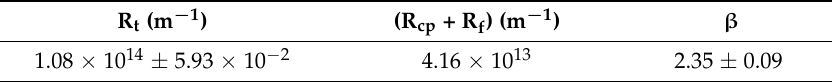
Table 5. Estimates of average total resistance ( ± RSD 1 ), resistance due to concentration polarisation, fouling resistance, and concentration polarisation modulus ( ± 0.09 RSD), obtained by applying the model described by the Equation